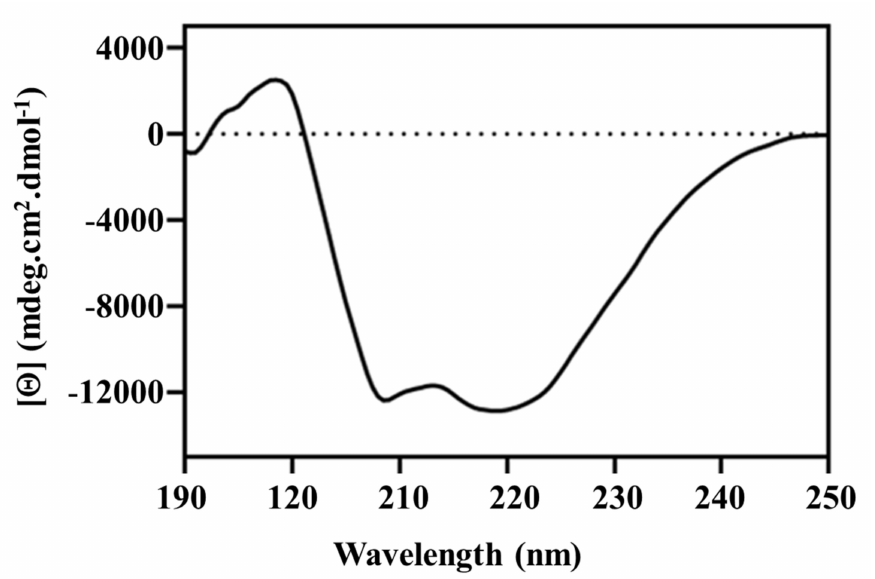
Figure 4. Secondary structural content of Sbh26GST determined via far-UV CD. The spectrum was obtained using 2 µ M protein in 5 mM Tris-HCl, pH 7.5, and 0.0002% ( w / v ) NaN 3 . Intrinsic Trp fluorescence of Sbh26GST was performed in the presence and absence of 100 µ M ligands. Sbh26GST contains four Trp residues within each subunit, all situated in the N -terminus thioredoxin-like domain with Trp206 closest to the active site. The